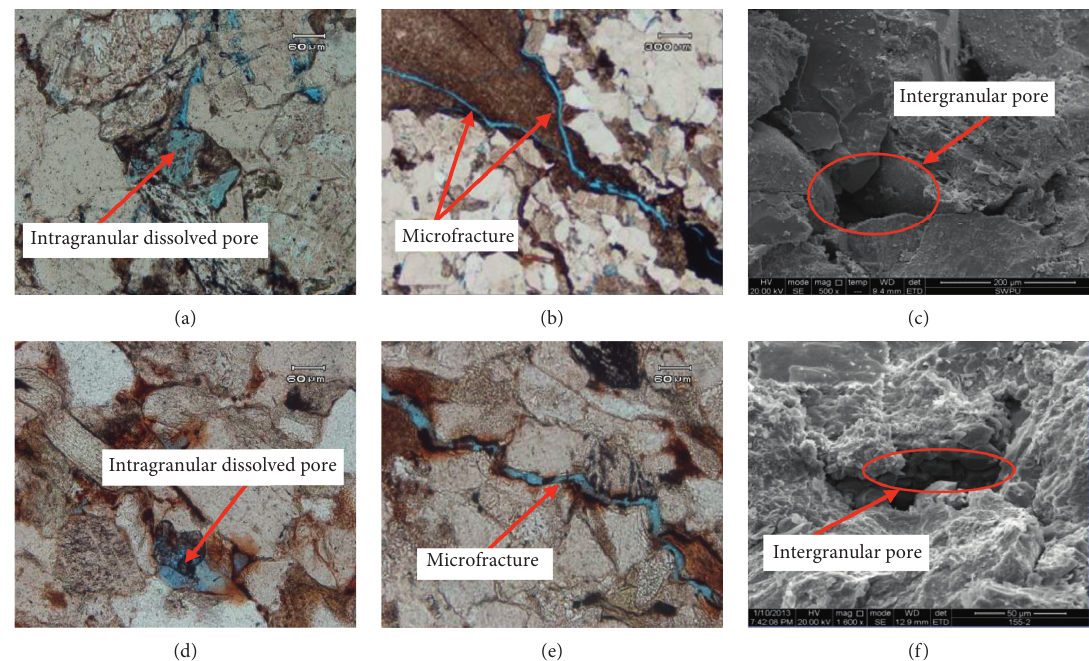
Figure 7: TS and SEM images of H and J oilfields. (a, b) Casting thin section (TS) images of H oilfield reservoirs. (c) Scanning electron microscopy (SEM) image of reservoir cores in H oilfield. (d, e) TS images of J oilfield reservoirs. (f) SEM image of reservoir cores in J